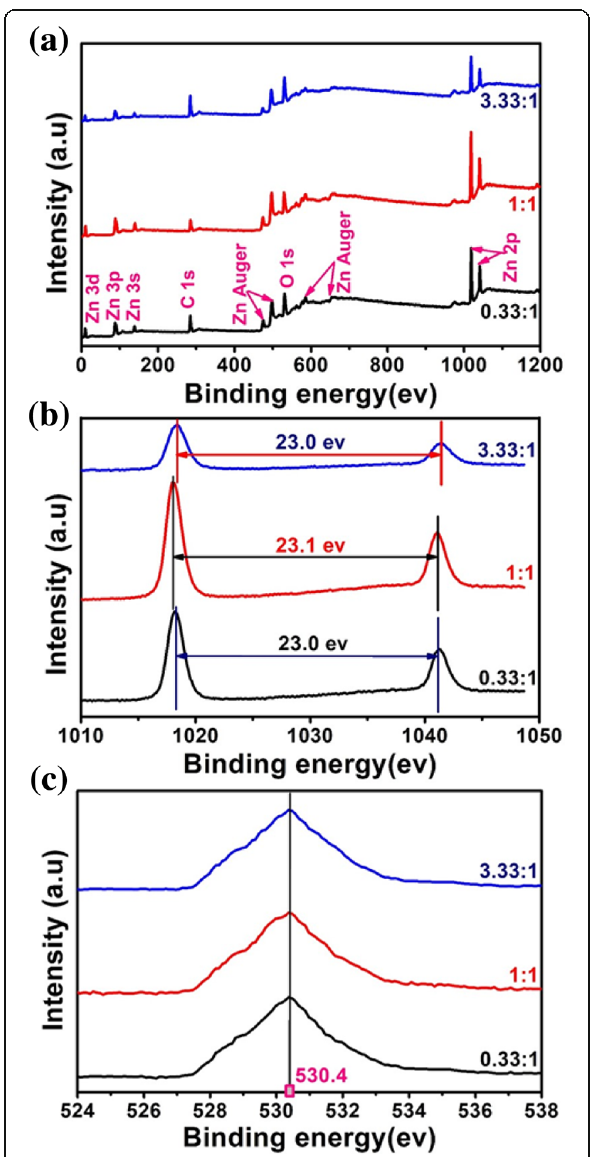
Fig. 4 XPS spectra of ZnO nanoparticles obtained from the different mole ratios of glycerol to Zn 2+ ( a , wide; b , Zn-2p; c , O-1s)